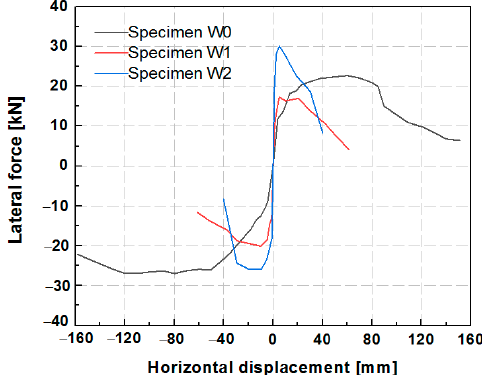
Figure 22. Hysteresis envelope curves of specimens W0, W1, and W2. Table 4. The seismic parameters of the three specimens.